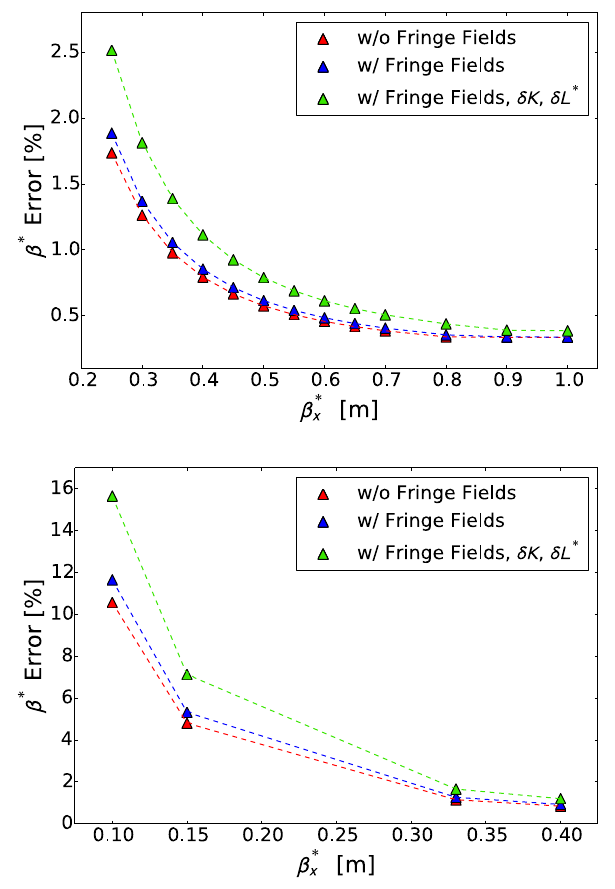
FIG. 7. Calculated errors using the analytical method for different contributions and for the range of LHC (top figure) and HL-LHC (bottom figure) optics. In red are the errors found for simulations without fringe fields. Results as presented before are shown when including fringe fields are shown in blue, while errors found when including uncertainties in K ð 0 . 1% Þ and L (cid:1) (6 mm) are shown in green.